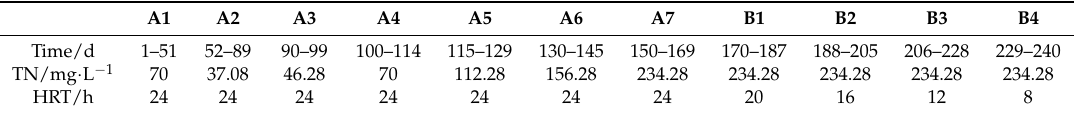
Table 3. Influent TN concentration and hydraulic retention time (HRT) of each stage of the biological filter